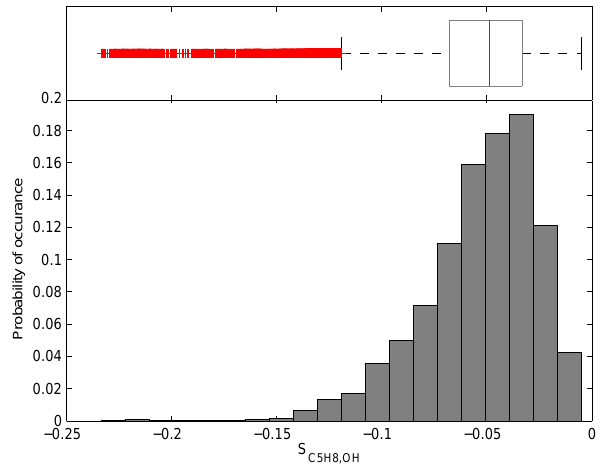
Fig. 6. Lower panel: Histogram showing probability of occurrence of S C based upon all 10:00–18:00LT calculations for the 5 H 8 , OH OP3-1 campaign. Upper panel: Box and whisker plot showing median (red line) and upper and lower quartiles (box). The up- per (lower) whisker encompasses the region within 3 times the re- gion between the upper (lower) quartile and the mean. Outliers are shown by a red